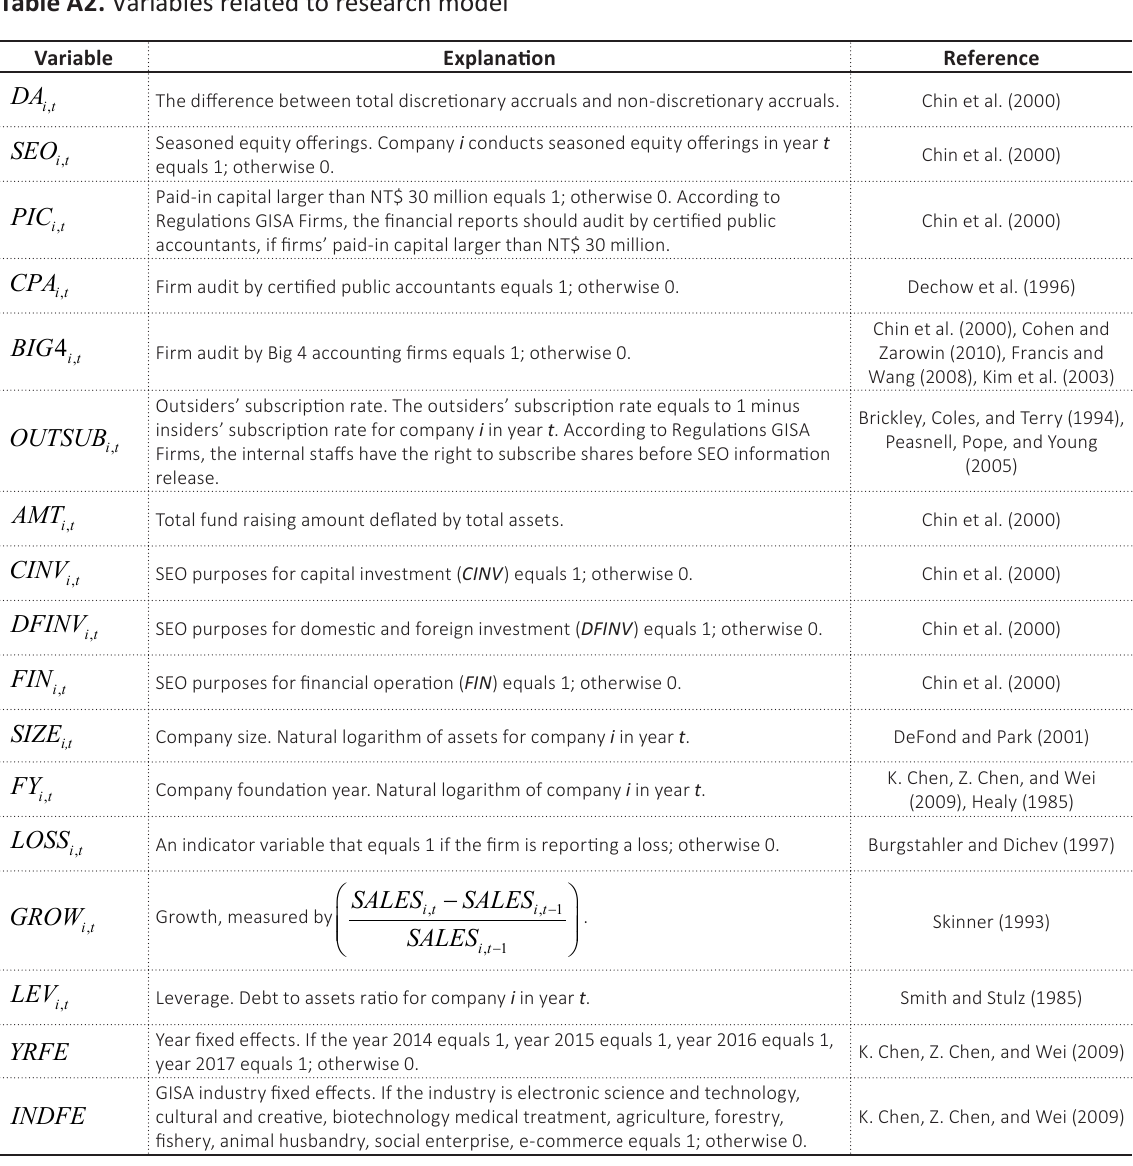
Table A2. Variables related to research